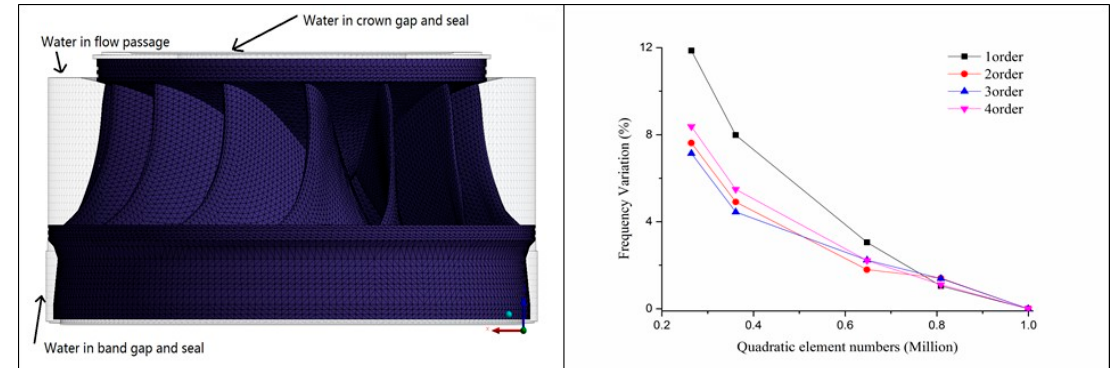
Figure 4. Mesh of the Francis turbine runner with the surrounding water ( left ) and mesh independence analysis results ( right ).